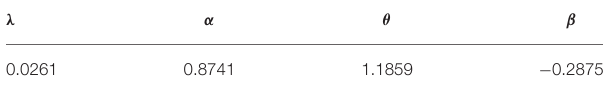
TABLE 9 | Minimal entropy parameters (NTS).